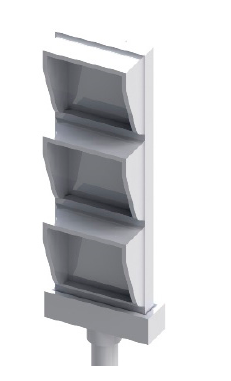
Figure 9. Three-dimensional model of the prototype.